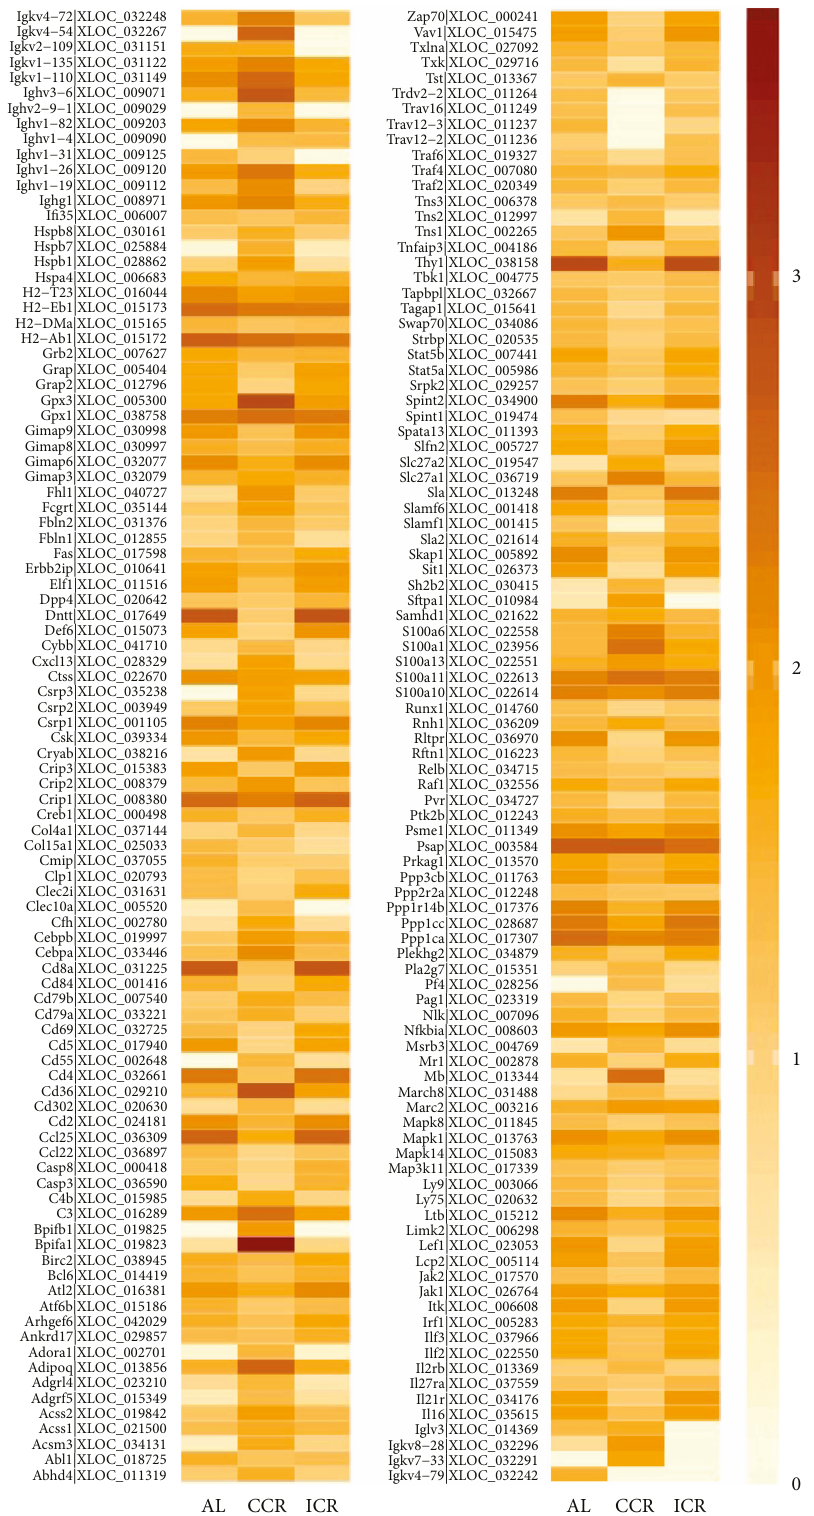
Figure 2: Heat map showing the expression pro fi les of signi fi cantly di ff erentially expressed genes between the AL, CCR, and ICR diet groups involved in immune response processes (GO: